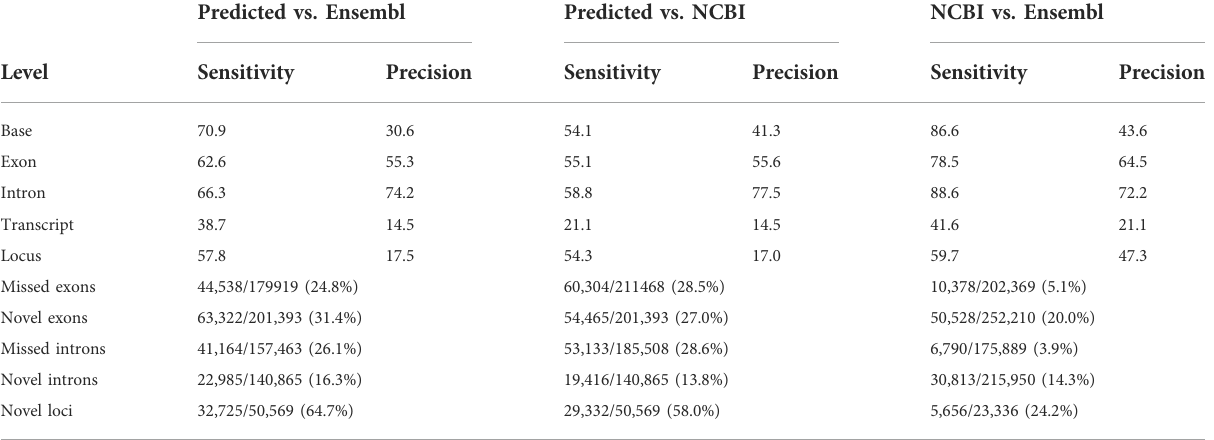
TABLE 1 Comparison of reference and predicted transcripts using GffCompare